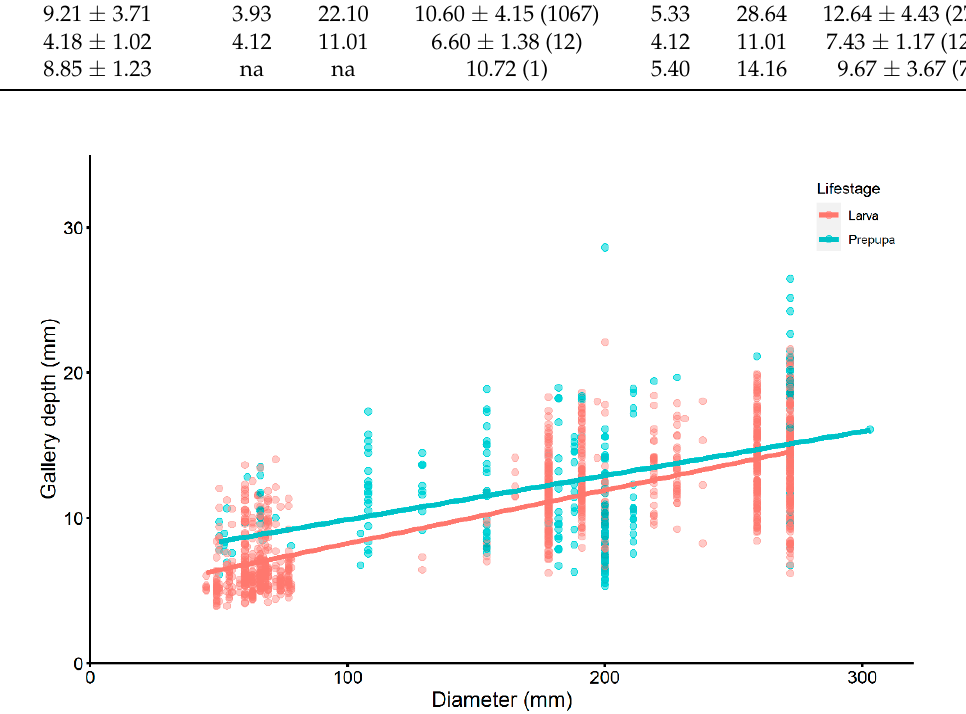
Figure 3. Gallery depths (mean ± SD) of immature Agrilus planipennis depending on the diameter of the sample and the lifestage.